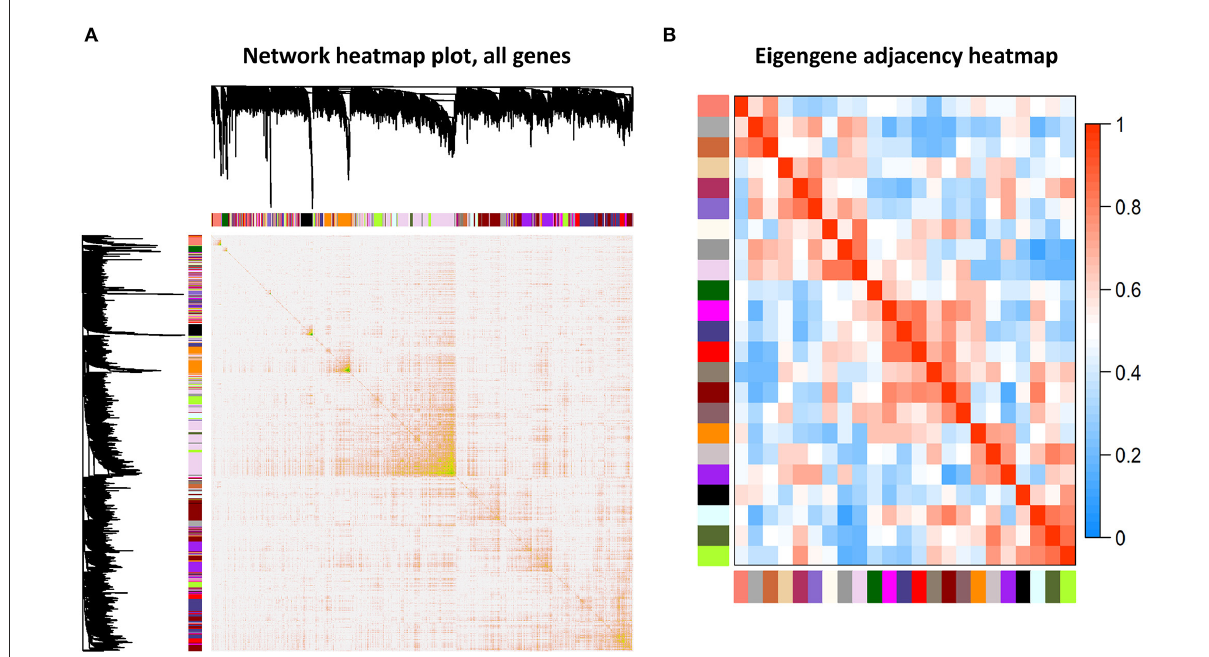
FIGURE4 Association analysis of modules. (A) Different colored bars represented different modules. The depth of color represented the tightness of the connection among different modules. Significant dissimilarity in the connectivity existed among different modules. (B) Heat map to display the eigengene adjacencies in some representative modules.